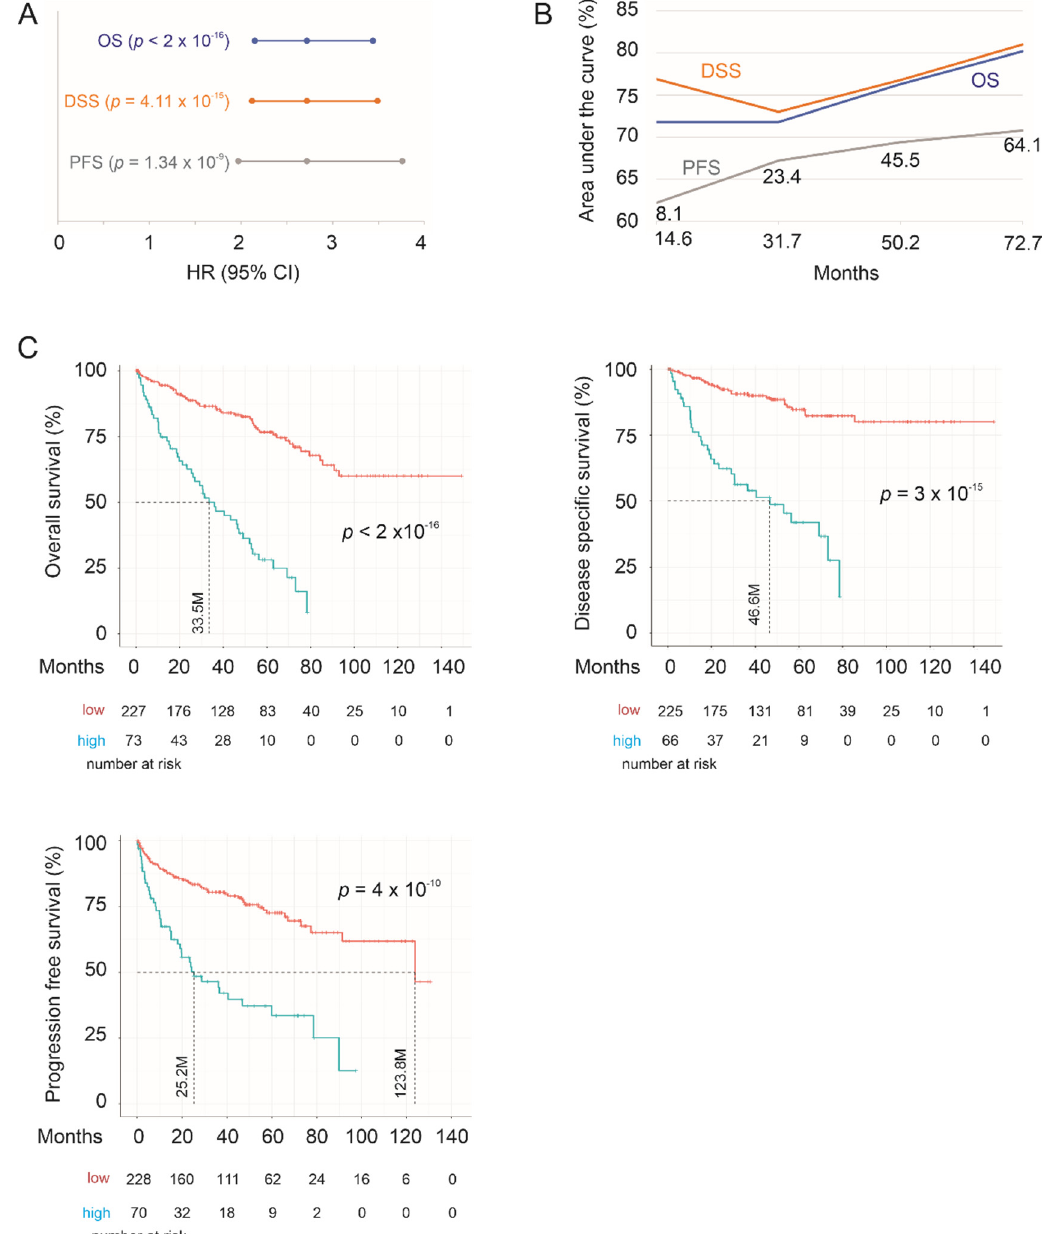
Figure 3. SigIQGAP1NW robustly stratifies risks of poor prognosis of ccRCC in the training sub-population. ( A ) HR, 95% CI, and p values. OS, overall survival; DSS, disease-specific survival; PFS, progression-free survival. ( B ) Time-dependent ROC (receiver operating characteristic) curve. Months for PFS are specifically labeled. ( C ) Kaplan Meier survival curves. Statistical analyses were performed using logrank test.